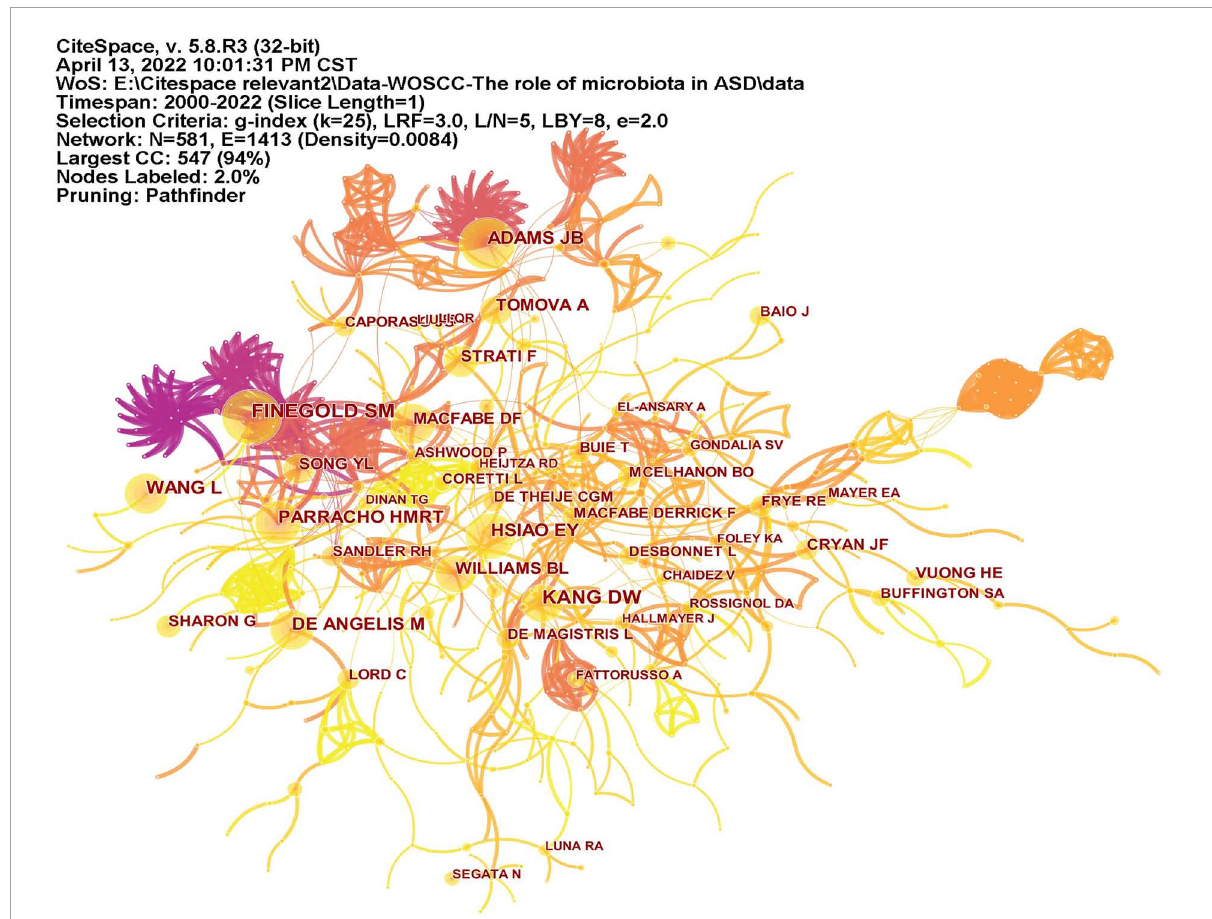
FIGURE6 The network of co-cited authors of publications. Lines indicate that two authors are jointly cited in an article. Line thickness is proportional to the number of co-cited articles.